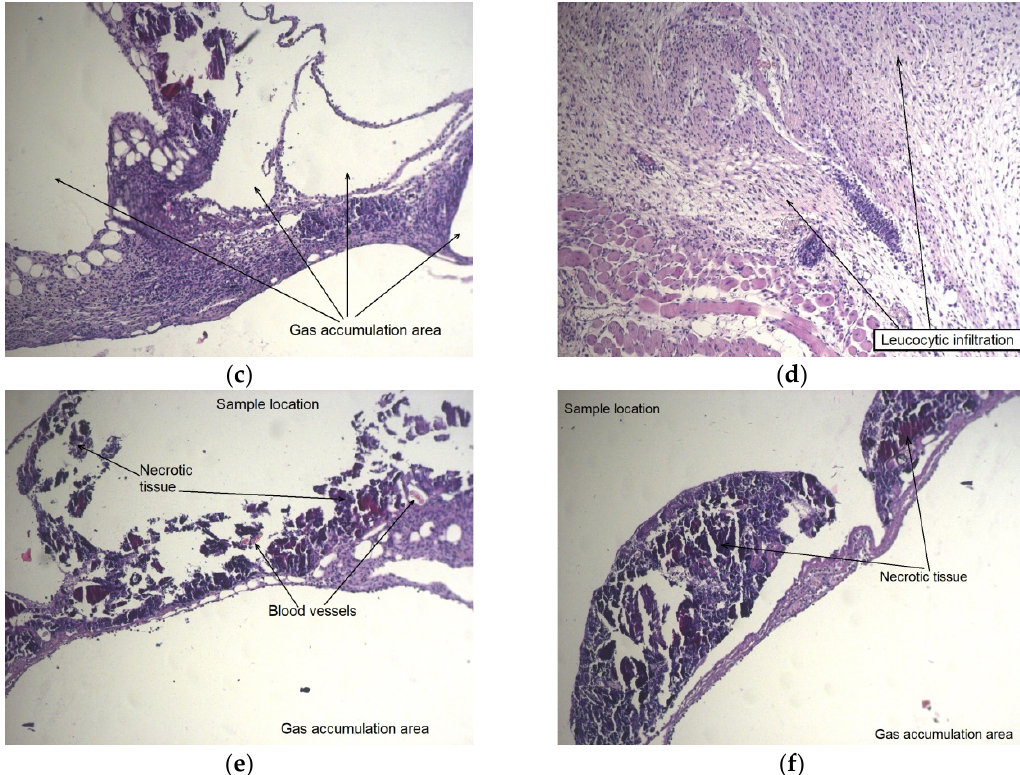
Figure 6. The sample of alloy WE43 in the initial state and the area around the implant two weeks after surgery: fragments of the sample inside the capsule, swelling and accumulation of gases in the surrounding tissue ( a ), results of histological examination of mouse tissues (hematoxylin–eosin (HE) staining) in the area of contact with the samples, showing the formation of large gas cavities, the expansion of blood vessels, the accumulation of biodegradation products, leucocyte infiltration, and contact tissue necrosis ( b–f ).